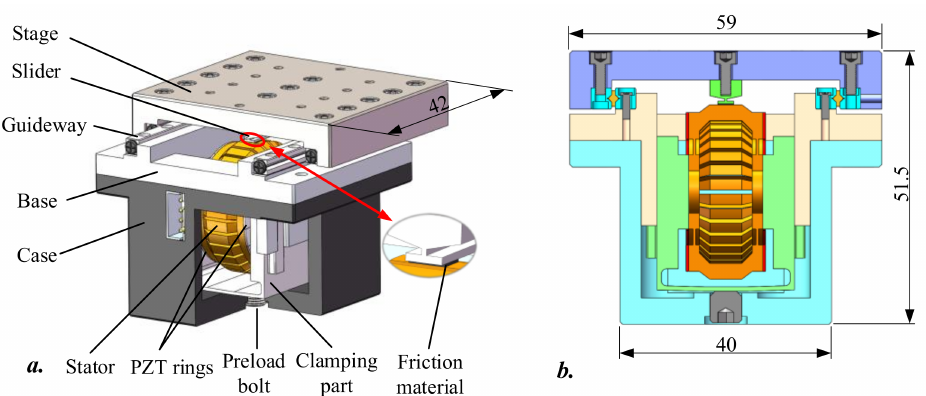
Figure 2. Structure of the proposed traveling wave LUSM: ( a ) three-dimensional model; ( b ) section